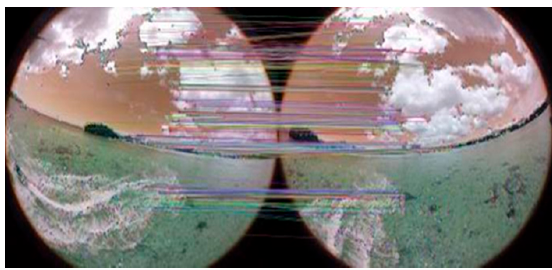
Figure 6. Feature matching between adjacent images.